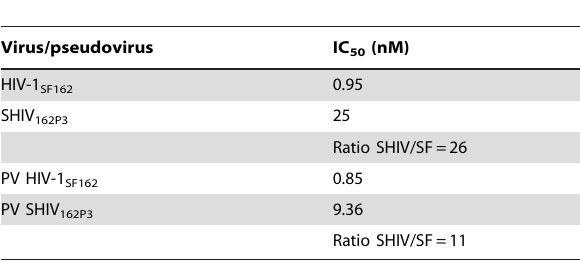
Table 1. Inhibition activity of M48U1 in TZM-bl exposed